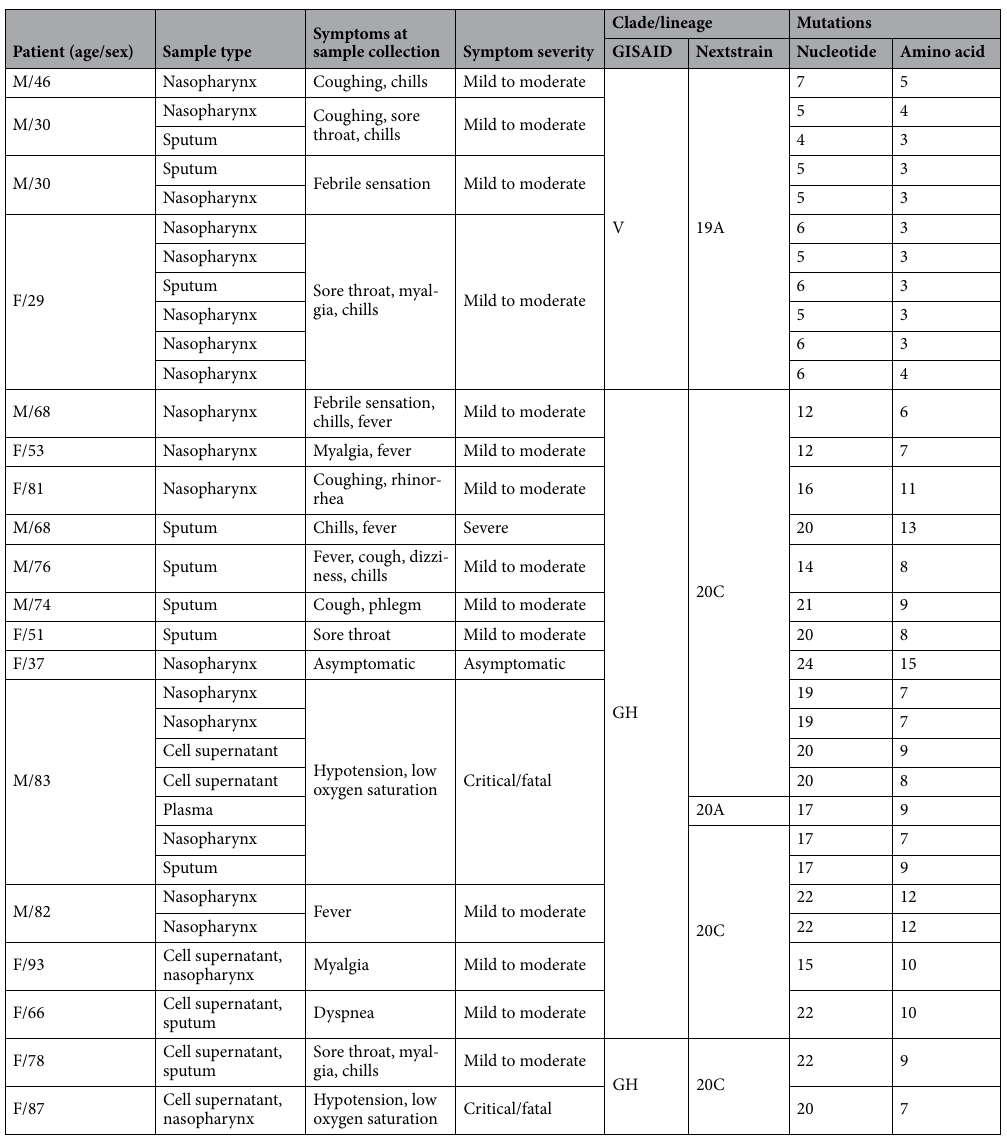
Table 1. Data on patient characteristics, sample types, symptoms at collection, clades, and number of mutations found in the SARS-CoV-2 genomes isolated from COVID-19